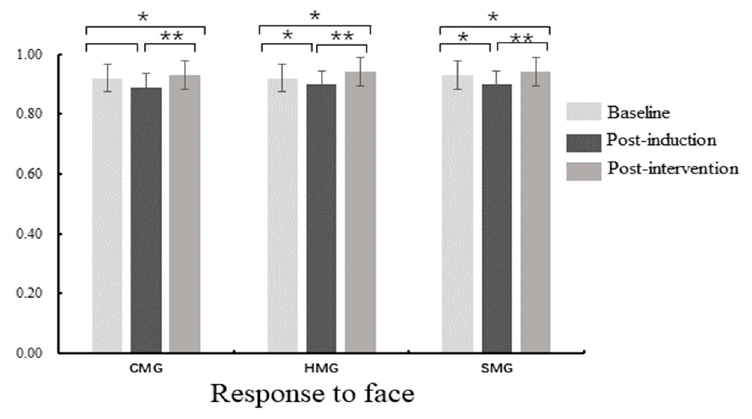
Figure 5. Accuracy (ACC) difference within-group in the face–word Stroop task; CMG: calm music group, HMG: happy music group, SMG: sad music group; * p < 0.05, ** p < 0.01.